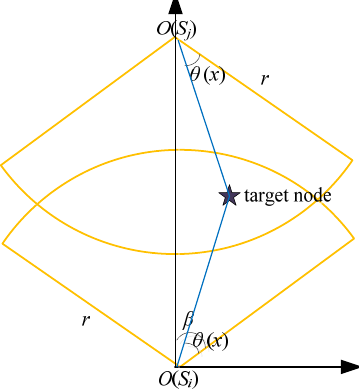
Figure 1. Directional sensing model of the nodes.